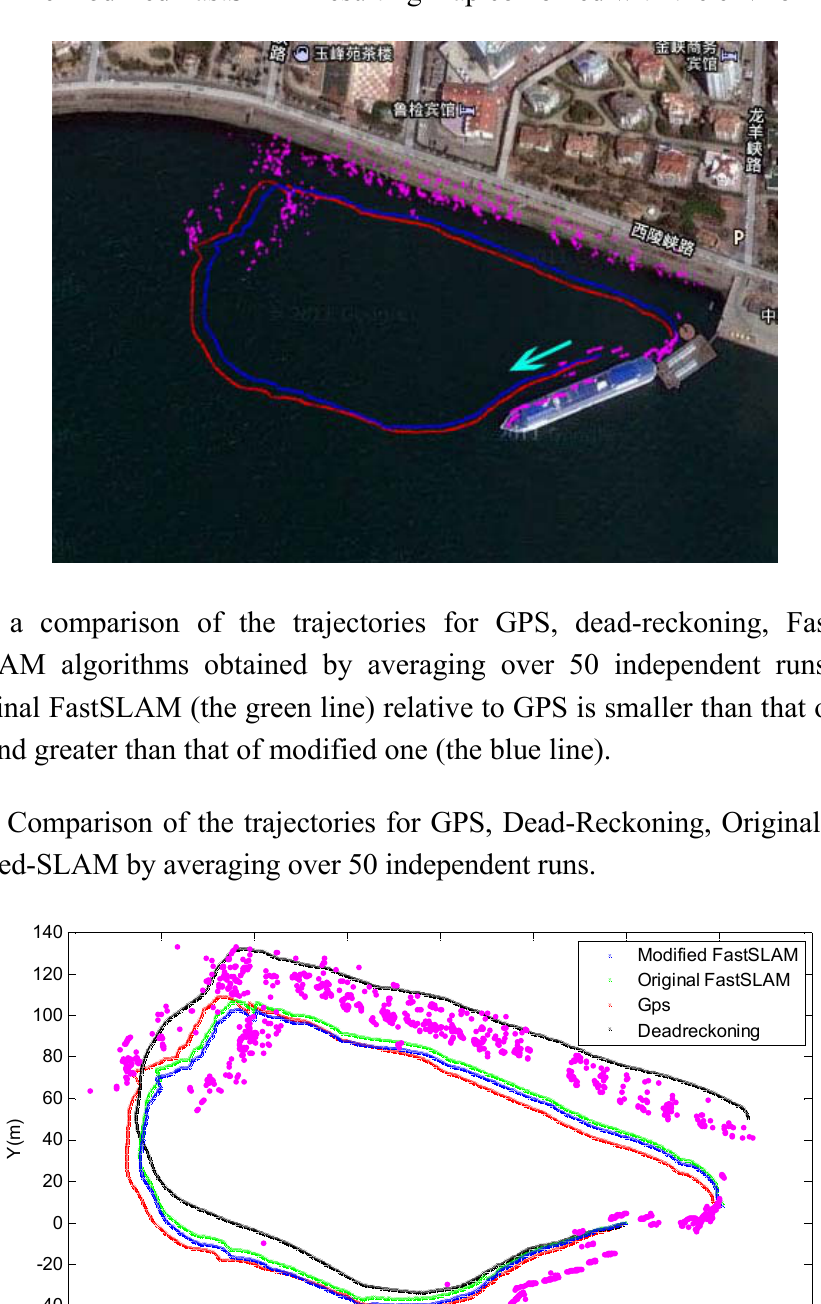
Figure 11. The modified FastSLAM resulting map combined with the environmental map.